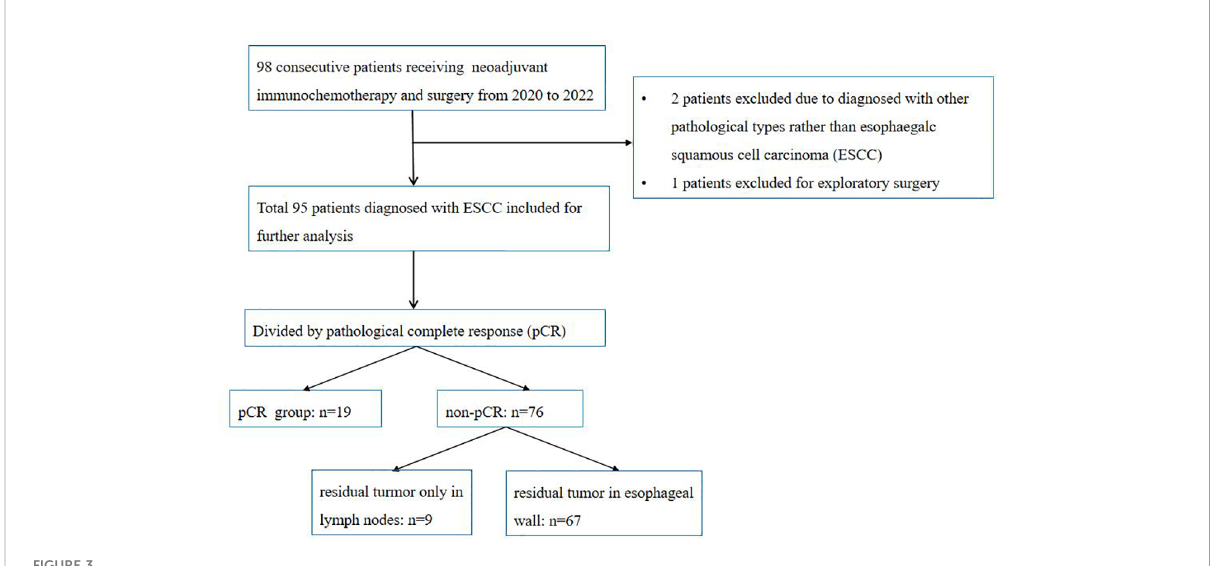
FIGURE 3 Patient selection fl